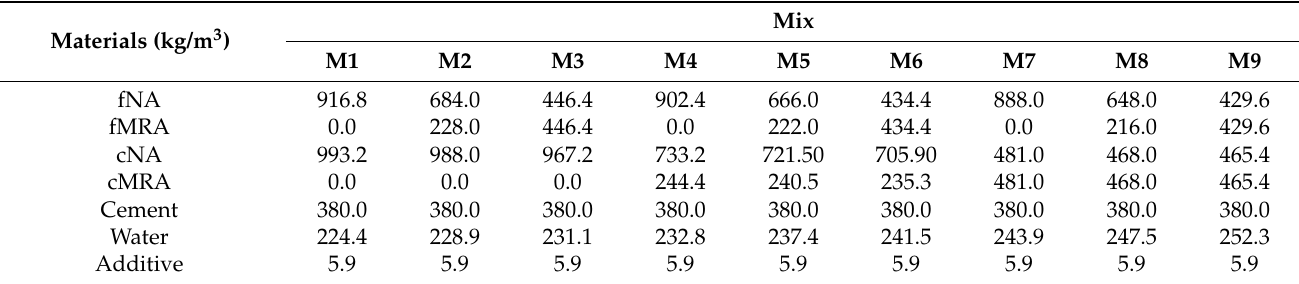
Table 5. Composition of the concretes designed.